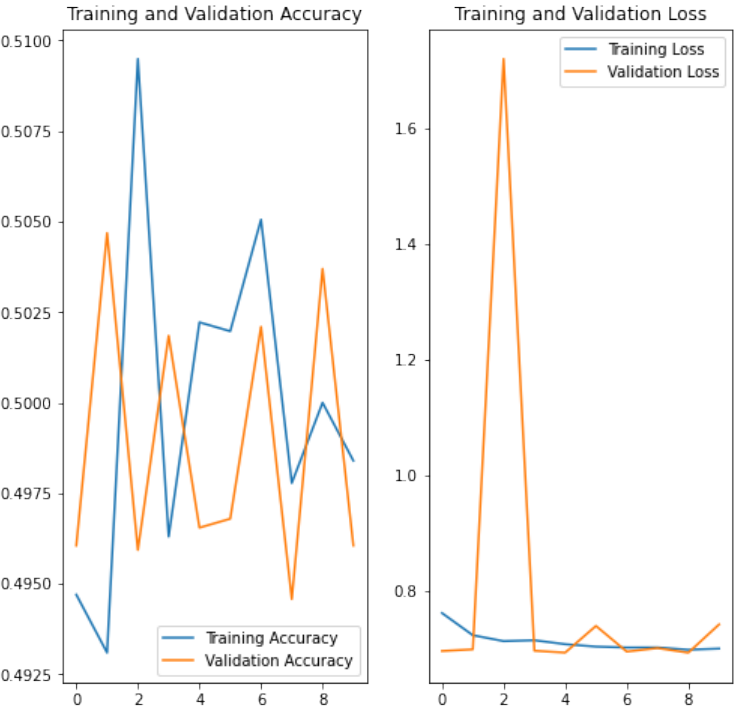
Figure 2. Validation Accuracy and Training Loss of Watermelon & Model 1 & 20